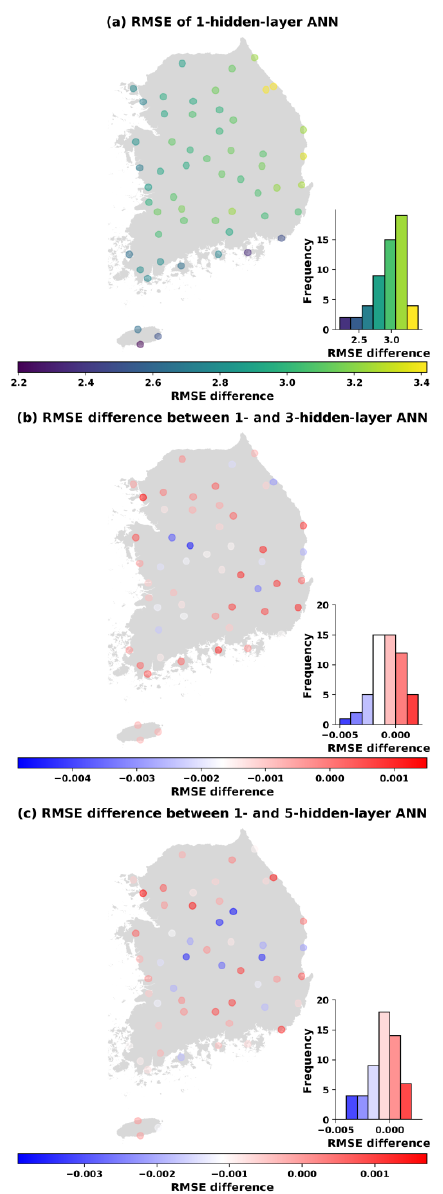
Figure 8. Panel ( a ) shows the RMSE of the test data of the 1-hidden layer model with 169 parameters; panel ( b ) shows the difference of the RMSE between the 1-hidden layer and the 3-hidden layer model (RMSE difference <0 indicates that the 1-hidden layer model performs better than the 3-hidden layer model and vice versa); and panel ( c ) shows the RMSE difference between the 1-hidden layer and the 5-hidden layer model (RMSE difference <0 indicates the that the 1-hidden layer model performs better, RMSE difference >0 shows the opposite).